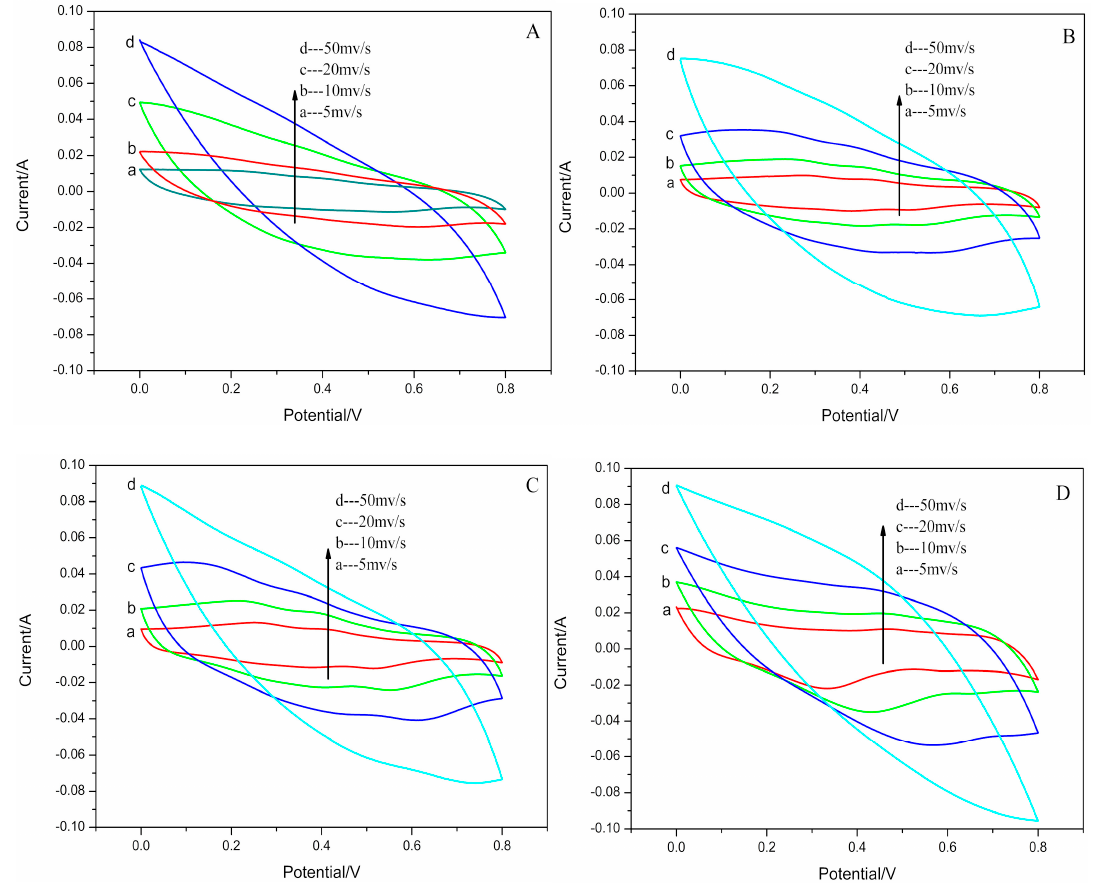
Figure 6. CV curves at different scan rates of ( A ) pure PANI, ( B ) PANI @ CQDs, ( C ) PANI @ FMWCNTs, and ( D ) FMWCNTs @ CQDs @ PANI.